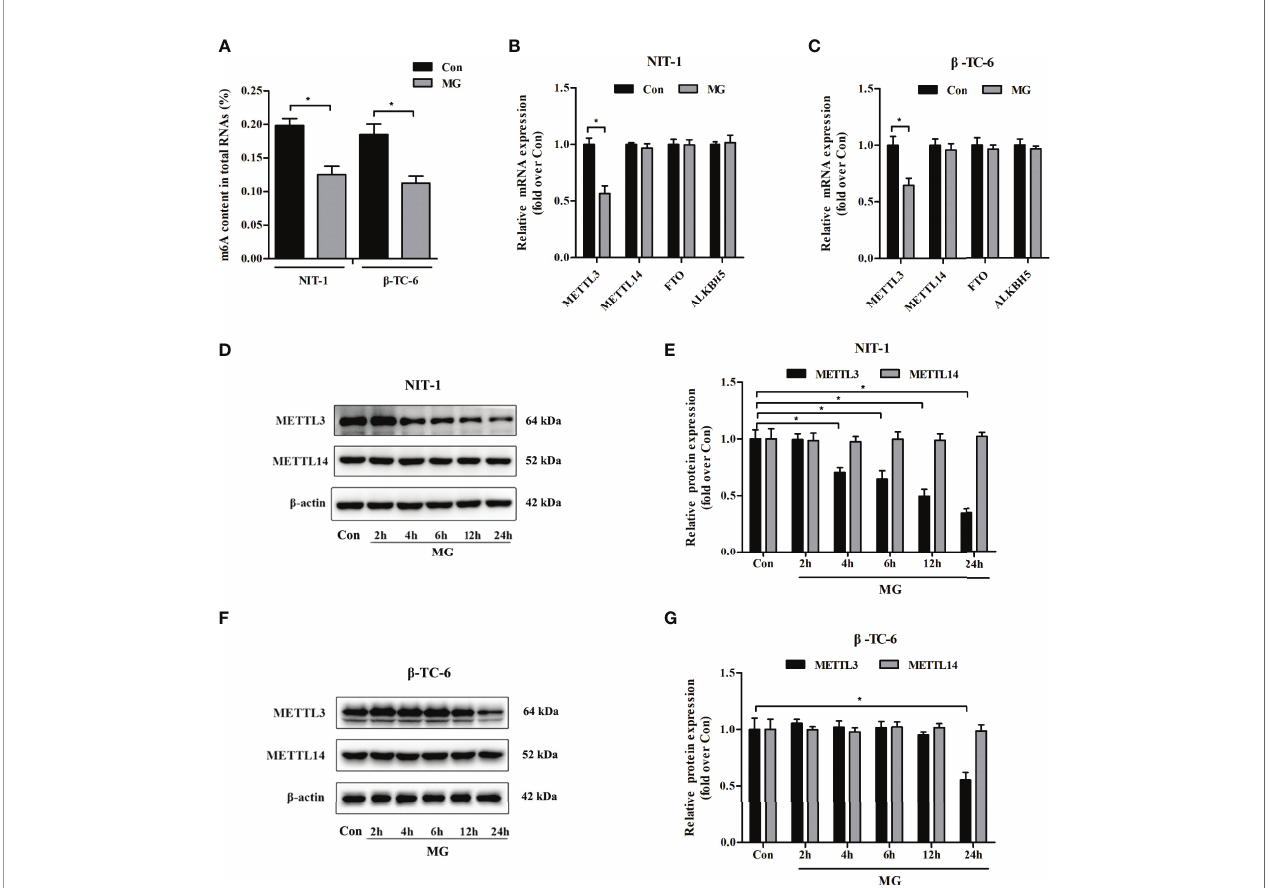
FIGURE 1 | Methylglyoxal (MG) treatment decreased m 6 A RNA methylation and METTL3 expression levels in pancreatic b cells. (A) m 6 A levels in total RNA from NIT-1 and b -TC-6 pancreatic b cells treated with 1 mM of MG (MG) for 24 h and untreated control cells (Con). (B, C) mRNA expression of the m 6 A methyltransferases METTL3 and METTL14 and the demethylases FTO and ALKBH5 in NIT-1 (B) and b -TC-6 (C) cells treated with 1 mM of MG for 24 h as measured by qPCR. The mRNA level of each gene was normalized to b -actin. (D – G) Immunoblotting of METTL3 and METTL14 protein expression levels in NIT-1 (D, E) and b -TC-6 (F, G) cells treated with 1 mM of MG for different time periods. b -Actin was used as an internal control. Results are presented as the means ± SD of 3 – 4 independent experiments. * p <